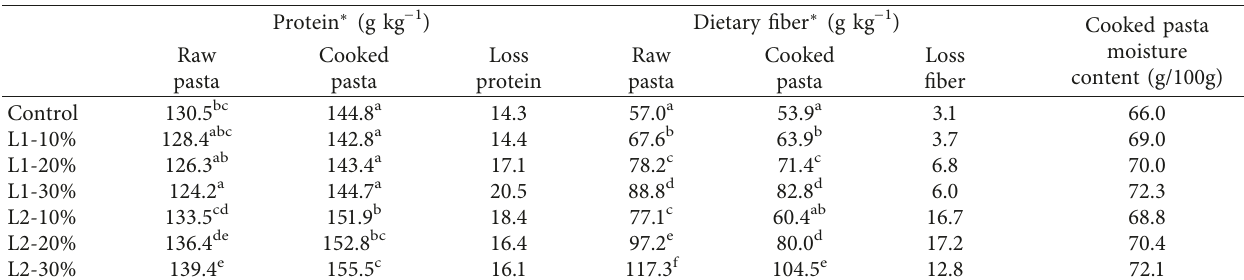
Figure 1: SEM micrographs of cooked pastas: (a, c) control samples (100% wheat flour); (b, d) L2-20% sample (20% kañawa flour and 80% wheat flour). (a, b) Outer edge of strand. (c, d) Centre of the Table 5: Protein and dietary fiber content of raw and cooked pastas.